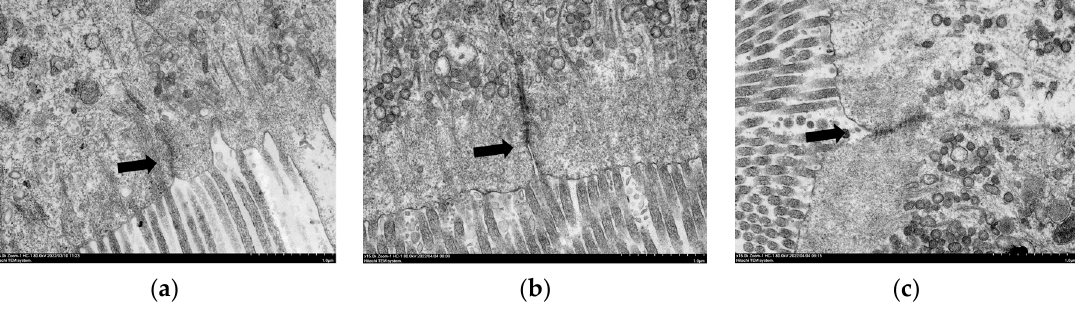
Figure 4. Transmission electron microscopy of intestinal mucosa in the hybrid grouper fed with various dietary histamine contents. ( a ) indicates H0 group; ( b ) indicates H24 group; and ( c ) indicates H96 group. Arrows indicate the junctions of the microvilli ends. The microvilli ends of intestinal mucosal cells in the H0 group were connected tightly between cells; in the H24 and H96 groups, gaps appeared between the microvilli ends of cells. The magnification was ×15.0 k, and the minimum scale (lower right) was 1.0 μ m.